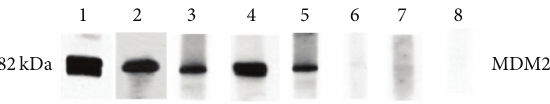
Figure 2: Western blot analysis with representative sera in ELISA. Lane 1, the polyclonal anti-MDM2 antibody was used as positive control. Lanes 2–5, four representative HCC sera which were pos- itive in ELISA also had strong reactivity with MDM2 recombinant protein in Western blot analysis. Lanes 6–8, three randomly selected NHS had negative reactivity with MDM2 recombinant